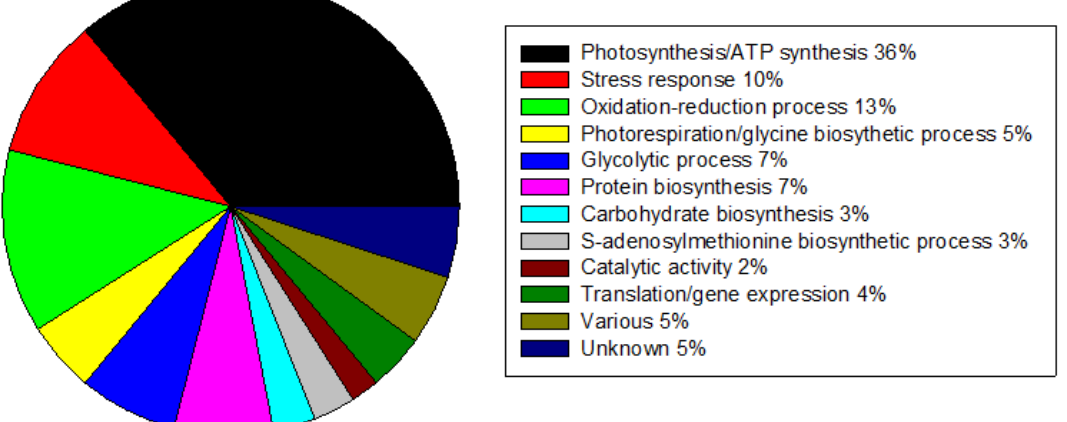
Figure 3. Expression of NtERD10A and ISPS genes in actual climate conditions. ( a ). Expression of the dehydrin NtERD10A gene was measured in non-emitting wild-type = NE-WT (grey) and isoprene-emitting line = IE-H (white) at different time points (T0: full color; T3: striped; T4: dotted). Levels from NtERD10A were normalized against L25 in each treatment. ( b ). Expression of ISPS gene was measured in IE-H line in each treatment. Levels from ISPS were normalized against L25 in each treatment. Means ( n = 3) ± SE are shown. A one-way ANOVA followed by a Tukey’s test was performed to define the statistical significance ( p < 0.05) of differences among means across the treatments. Different letters show statistically significant differences.